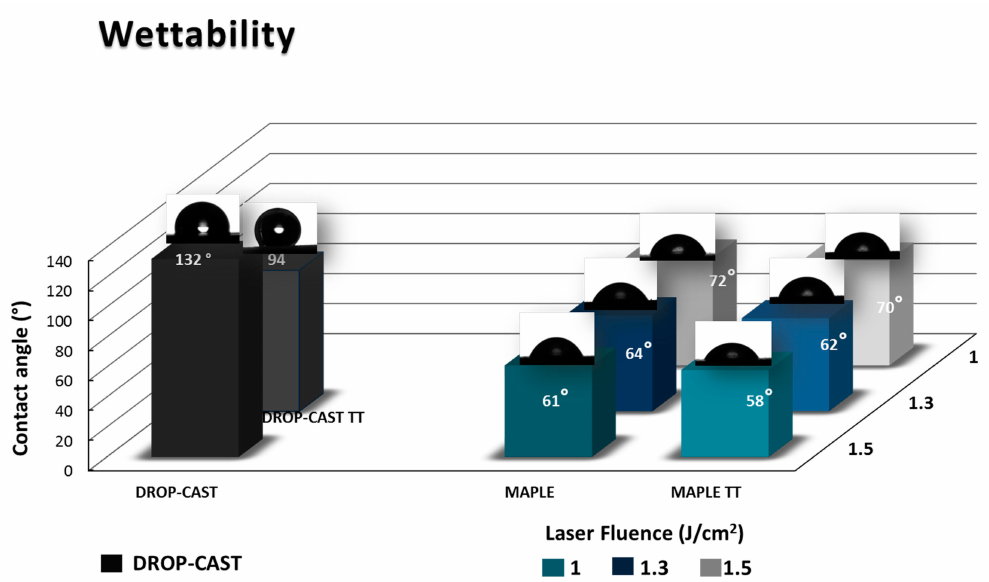
Figure 5. Contact angle comparison of PVDF bulk: drop-cast and drop-cast-TT with PVDF-MAPLE and PVDF-MAPLE TT at di ff erent laser fluences (1.0, 1.3, and 1.5 J / cm 2